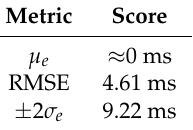
Table 2. Main SCG annotation performance: population-wide